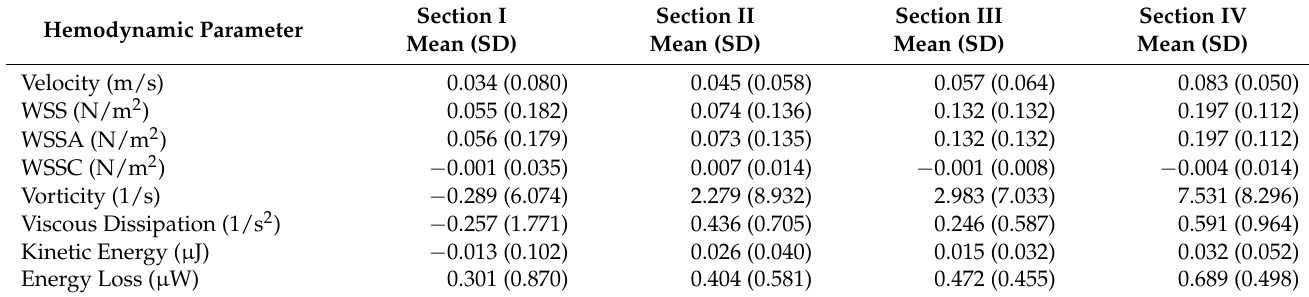
Table A1. The Bland–Altman plots for the mean and standard deviation (Bland–Altman plots